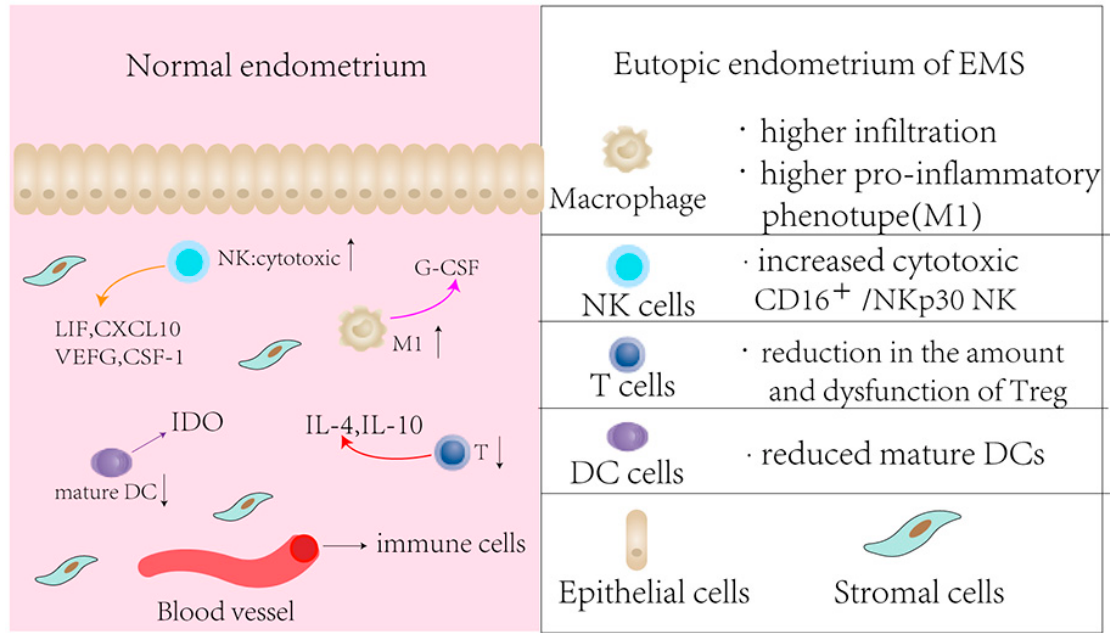
Figure 3. Schematic presentation of the endometrial immune environment of women with